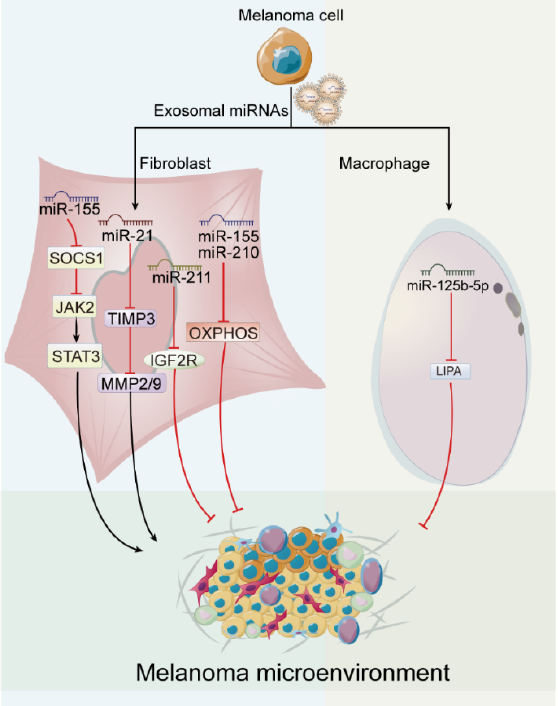
Figure 4. Roles of exosome-derived miRNAs in melanoma microenvironment. Exosomal miRNAs generate a melanoma-friendly microenvironment through inducing fibroblasts and macrophages into cancer-associated fibroblasts (CAFs) and tumor-associated macrophages (TAMs), respectively.